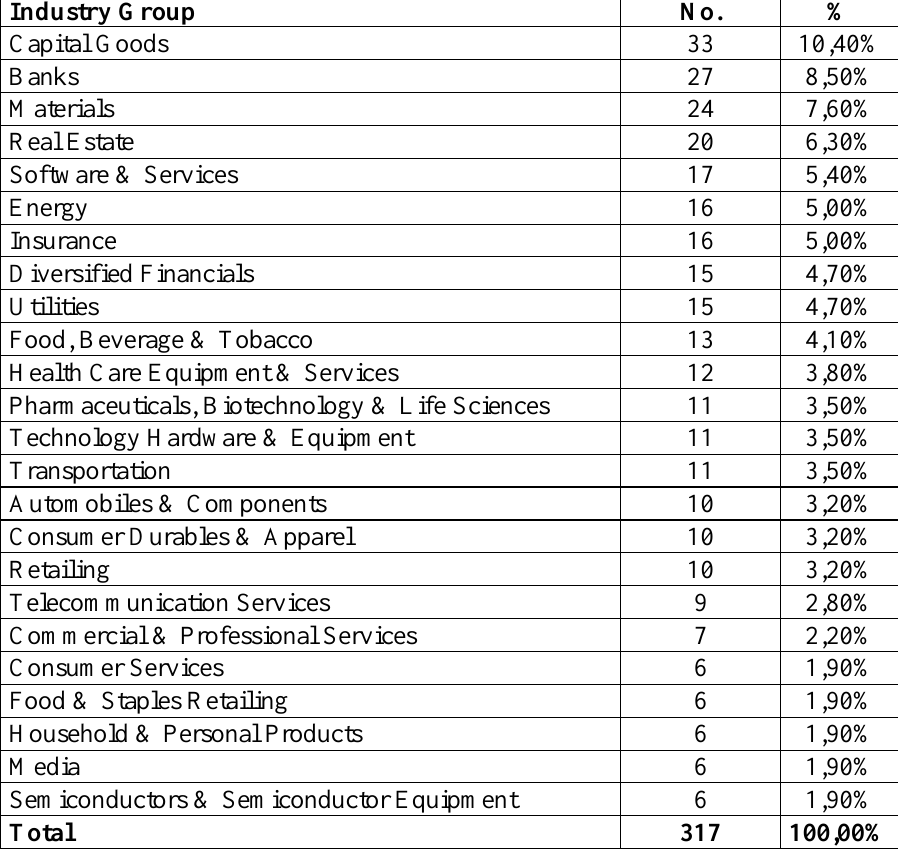
Table 1: DJSI Listed Companies by Industry Groups (Update May